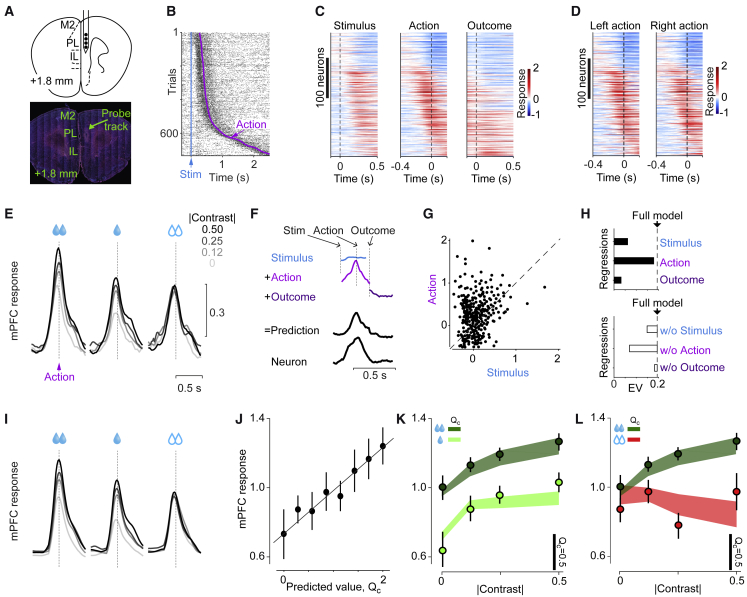
Medial Prefrontal Neurons Encode Confidence-Dependent Predicted Value(A) Histological image showing the high-density silicon probe track in mPFC.(B) Raster plot showing spikes of an example mPFC neuron, aligned to the stimulus onset (blue line) with trials sorted by action onset (purple dots).(C) Responses of all task-responsive neurons (n = 316), aligned to the time of stimulus, action, or outcome, sorted according to the time of maximum response in the middle panel. Responses were Z scored and averaged over all stimulus contrasts and possible outcomes.(D) Same as the middle panel of (C) for trials with maximum stimulus contrast with left or right actions.(E) Mean population activity (n = 316 neurons) triggered on action onset for correct choices toward the large-reward side (left), correct choices toward the small-reward side (middle), and incorrect choices toward the large-reward side (right). Responses for incorrect choices toward the small-reward side were smaller (p = 0.015, signed-rank test, data not shown) but such trials were rare. See Figure S2A for responses shown separately for neurons activated or suppressed at the time of the action. See Figure S2B for population activity triggered on outcome onset.(F) The regression analysis estimates a temporal profile for each task event, which in each trial is aligned to the event onset time and scaled by a coefficient. The results are summed to produce predicted traces.(G) The size of action and stimulus profiles for the full regression. Each dot presents one neuron (n = 316).(H) Top: cross-validated explained variance (EV) averaged across neurons (n = 316) for the full regression (dotted line) and for regressions each including only one type of event (bars). Bottom: variance explained by full regression (dotted line) and regressions each excluding one of the events (bars).(I) Predictions of the regression only including action events triggered on action onset, as a function of stimulus contrast and trial type.(J) Average action responses (estimated by regression on mPFC activity) as a function of trial-by-trial decision value QC (estimated from the behavioral model). Trial-by-trial variations in action-related activity (estimated from the regression) better correlated with QC in neurons with positive profile, i.e., activated neurons, compared to neurons with negative profile, i.e., suppressed neurons (Figure S2E, p = 0.011, signed-rank test), consistent with results from averaging across neuronal responses (Figure S2A).(K) Average action responses in correct trials as a function of stimulus contrast and reward size. Circles: mean; error bars: SE across neurons; shaded regions: model estimate of QC.(L) Same as (K) but for correct and error trials to the large-reward side. In (J)–(L), only neurons with significant action profile were included (241/316 neurons). See Figures S2F and S2G for responses of remaining neurons.